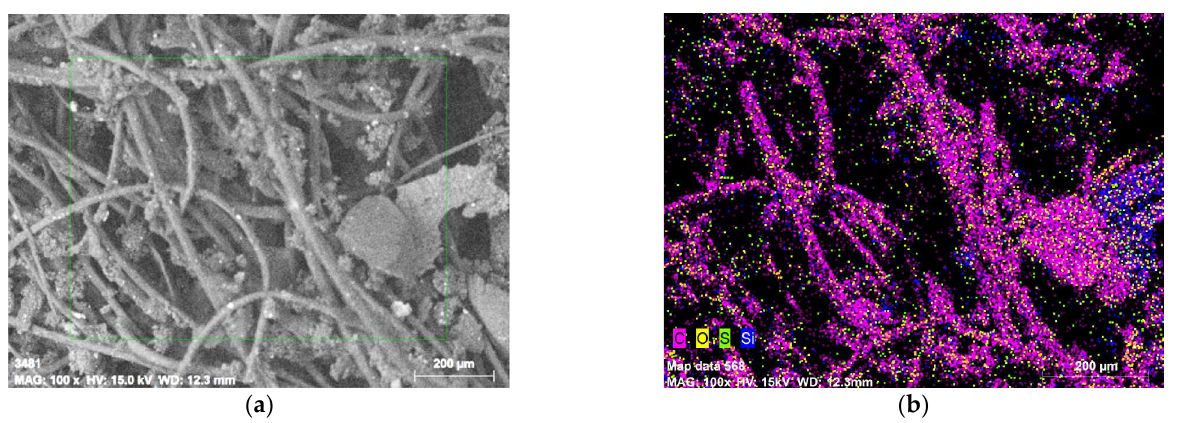
Figure 1. SEM-EDX images from WTTF used in this study. ( a ) Original SEM image, and ( b ) elemental distribution detected in the image.